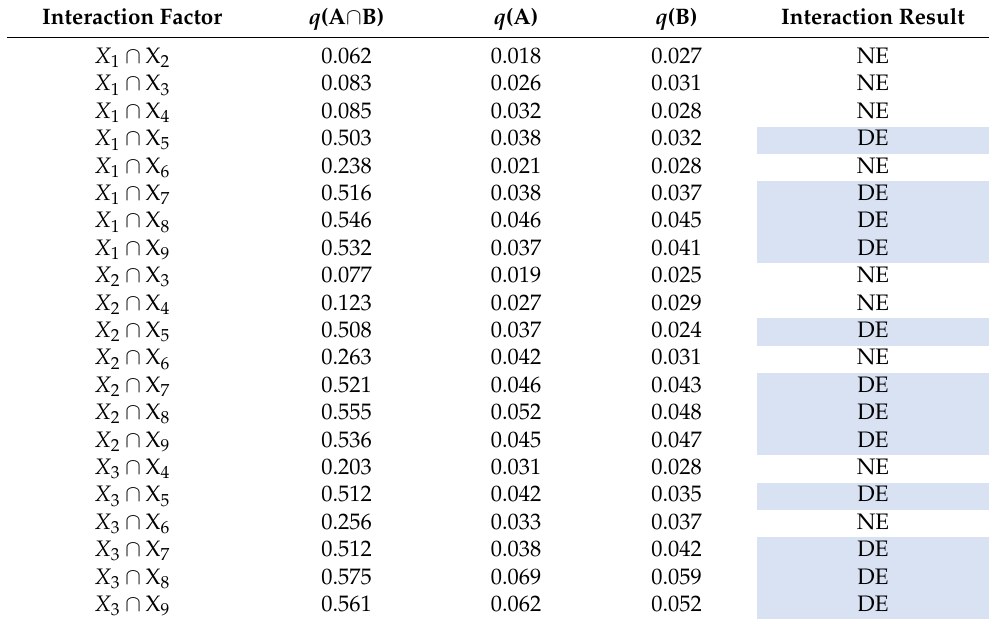
Table 6. Interactive detection values of factors influencing rural settlements. Interaction